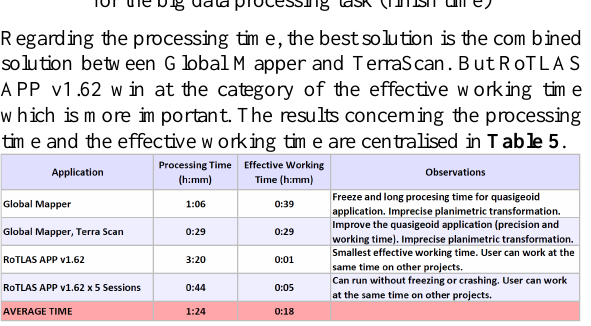
Table 5 . Results on the processing time of 10GB LAS